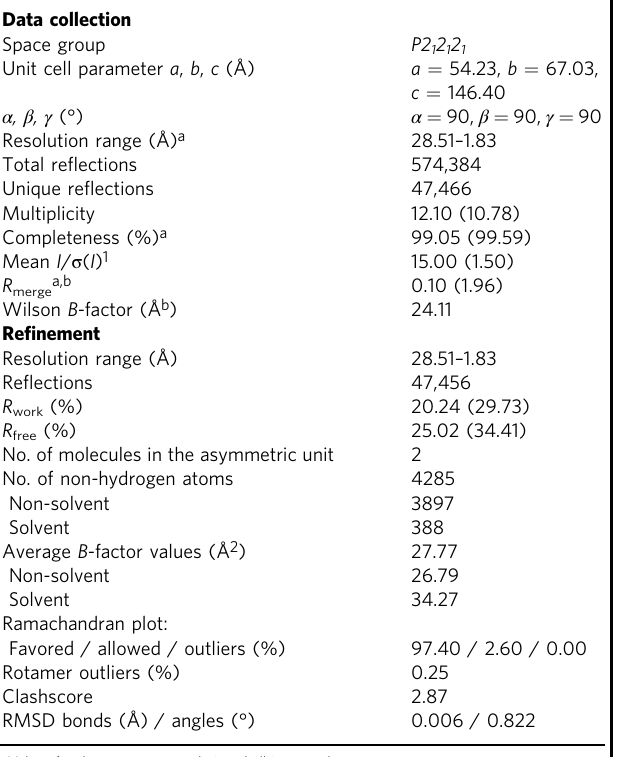
Table 1 Data collection and re fi nement statistics. Data collection Space